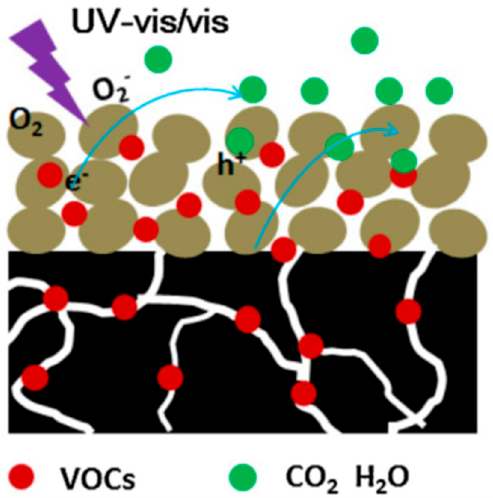
Figure 10. Schematic mechanism of the proposed photocatalytic oxidation of volatile organic compounds (VOCs) in O 2 under UV–vis and visible light irradiation for mesoporous TiO 2 /hydro-CF. Mesoporous TiO 2 films (brown spots) can be excited to form e − /h + under UV–vis and visible light irradiation. The h + is one of the strong oxidant for gaseous VOCs mineralization. Moreover, TiO 2 /hydro-CF substrate adsorb the VOCs molecules increasing the concentration of VOCs at the interfacial between of photocatalyst and substrate, as well as facilitate the mass transfer of VOCs due to the macroporous structure. Reproduced with permission from [82]. Copyright © 4472401418350, 2018 Elsevier.